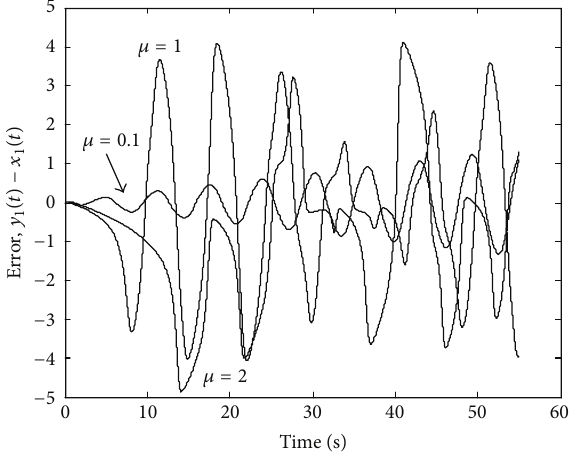
Figure 12: Error between 𝑦 1 (𝑡) and 𝑥 1 (𝑡) for different values for 𝜇 .